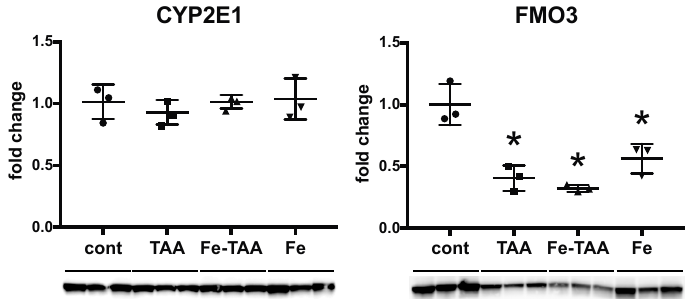
Figure 5. Hepatic expression of anti-cytochrome P450 2E1 (CYP2E1) and anti-flavin containing monooxygenase (FMO-3) at week 6. Data are expressed as mean ± SD. * p < 0.05 vs. cont., by Tukey’s multiple comparison.